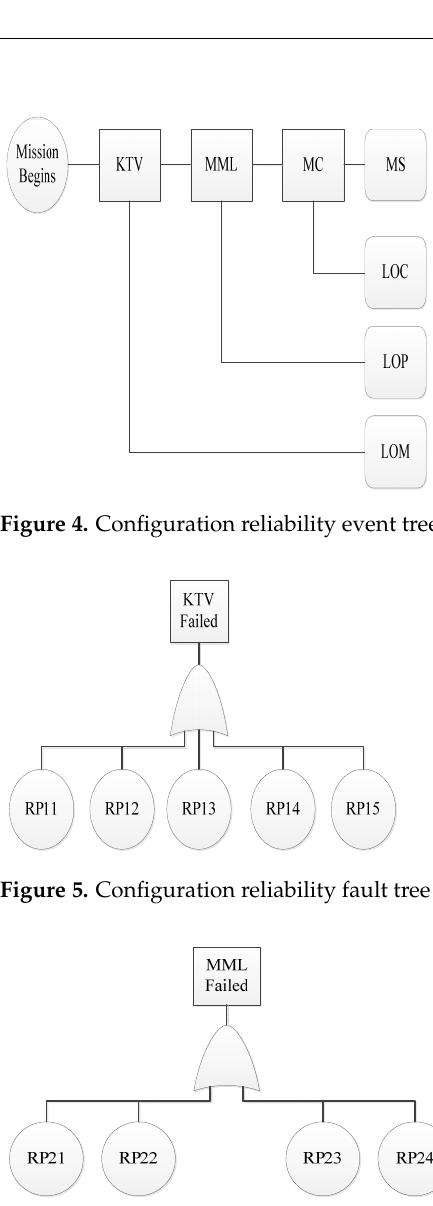
Figure 6. Configuration reliability fault tree model of the MML phase.